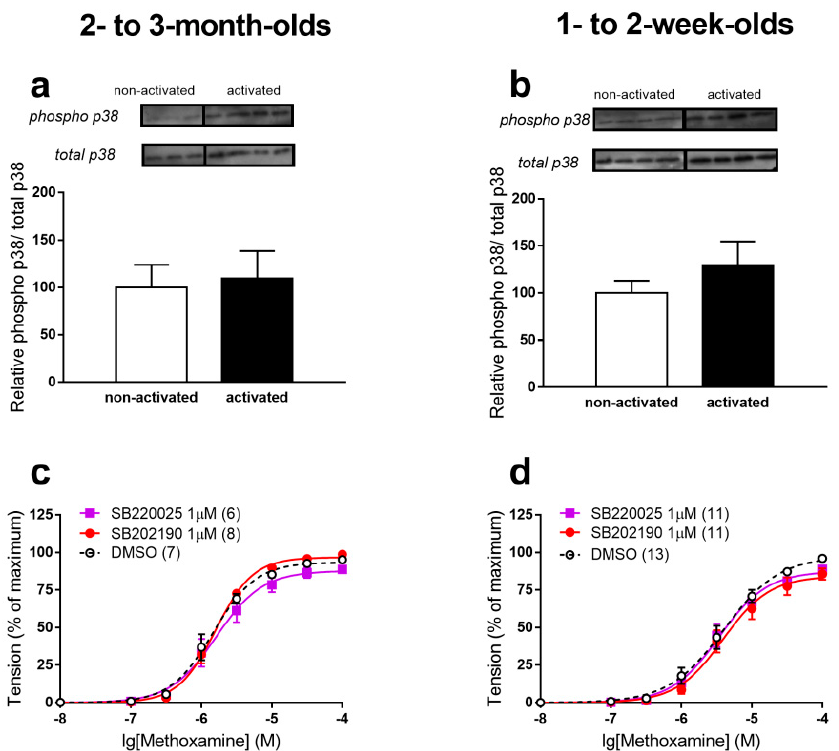
Figure 2. p38 MAPK does not contribute to contractile responses of rat saphenous arteries to MX. ( a , b ). Phosphorylation level of p38 MAPK in arteries of 2- to 3-month-old (( a ), n = 3 for non-activated and n = 4 for activated vessels) and 1- to 2-week-old (( b ), n = 4 for non-activated and n = 4 for activated vessels) rats. ( c , d ). Concentration-response relationships to MX in the presence of 1 µ M SB202190, 1 µ M SB220025 or DMSO (vehicle of the inhibitors) of arteries from 2- to 3-month-old ( c ) and 1- to 2-week-old ( d ) rats. Numbers in parenthesis indicate the number of animals. Further, we compared phosphorylation levels of p42/44 MAPKs before and during the MX-induced stimulation of arteries of 2- to 3-month-old and 1- to 2-week-old rats and the effects of a p42/44 MAPK inhibitor on MX-induced contractile responses (Figure 3a– d). The phosphorylation level of p42 MAPK increased after MX-induced stimulation in arteries of 2- to 3-month-old rats; this was not observed in arteries of 1- to 2-week-old rats. The phosphorylation level of p44 MAPK after MX-induced stimulation increased slightly erably augmented in arteries of 2- to 3-month-old rats (approximately 3 times, Figure 3c). The higher degree of p42/44 MAPK activation in arteries of 2- to 3-month-old animals to its inactive analogue U0124, U0126 decreased contractile response to MX in arteries of